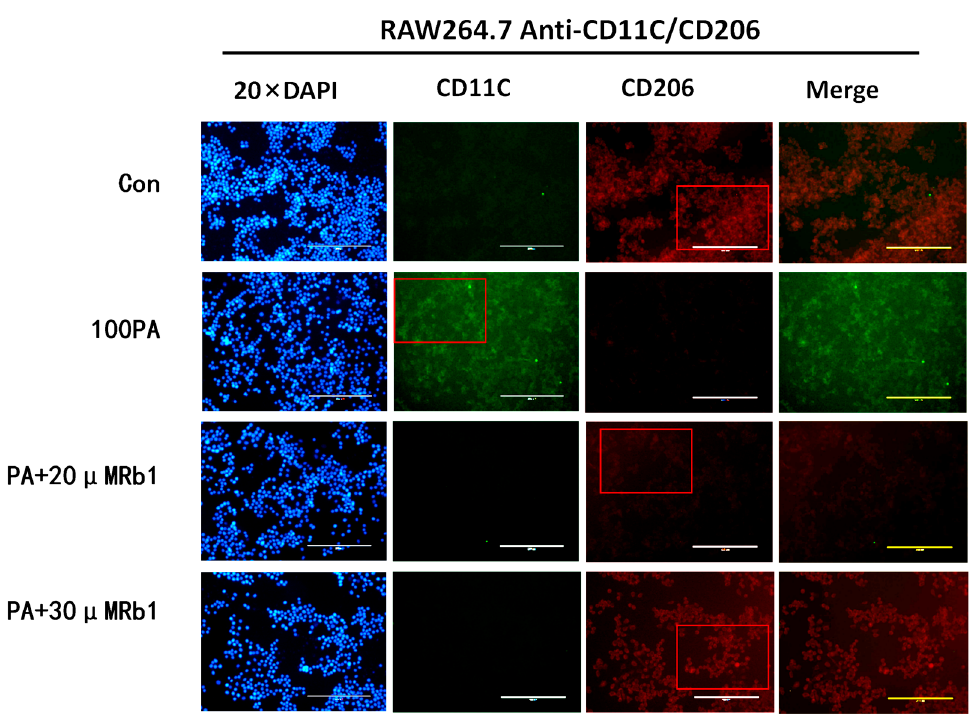
Figure 6. The expression of M1 and M2 types (20×). Con: control group; 100 PA: mature adipocyte supernatant was incubated with 100 µM PA; 100 PA + 10 µM Rb1 and 20 µM: mature adipocyte supernatant and ginsenoside Rb1 were incubated with 100 µM PA + 10 µM Rb1 and 20 µM Rb 1.